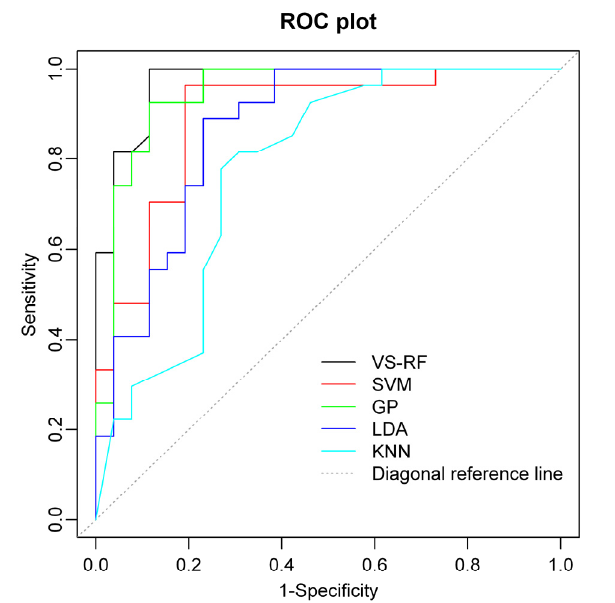
Figure 2. The ROC (receiver operating characteristic) curves of VS-RF, SVM, GP, LDA and k NN for the prediction